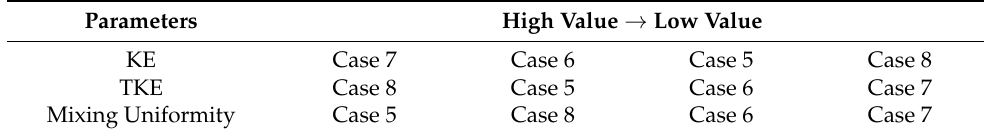
Figure 6. Comparison of the in-cylinder methane mass fraction distribution between Case 3 and Case 4. Table 3. Comparison of the KE, TKE, and mixing uniformity of Cases 5–8. Table 3. Comparison of the KE, TKE, and mixing uniformity of Cases 5–8.